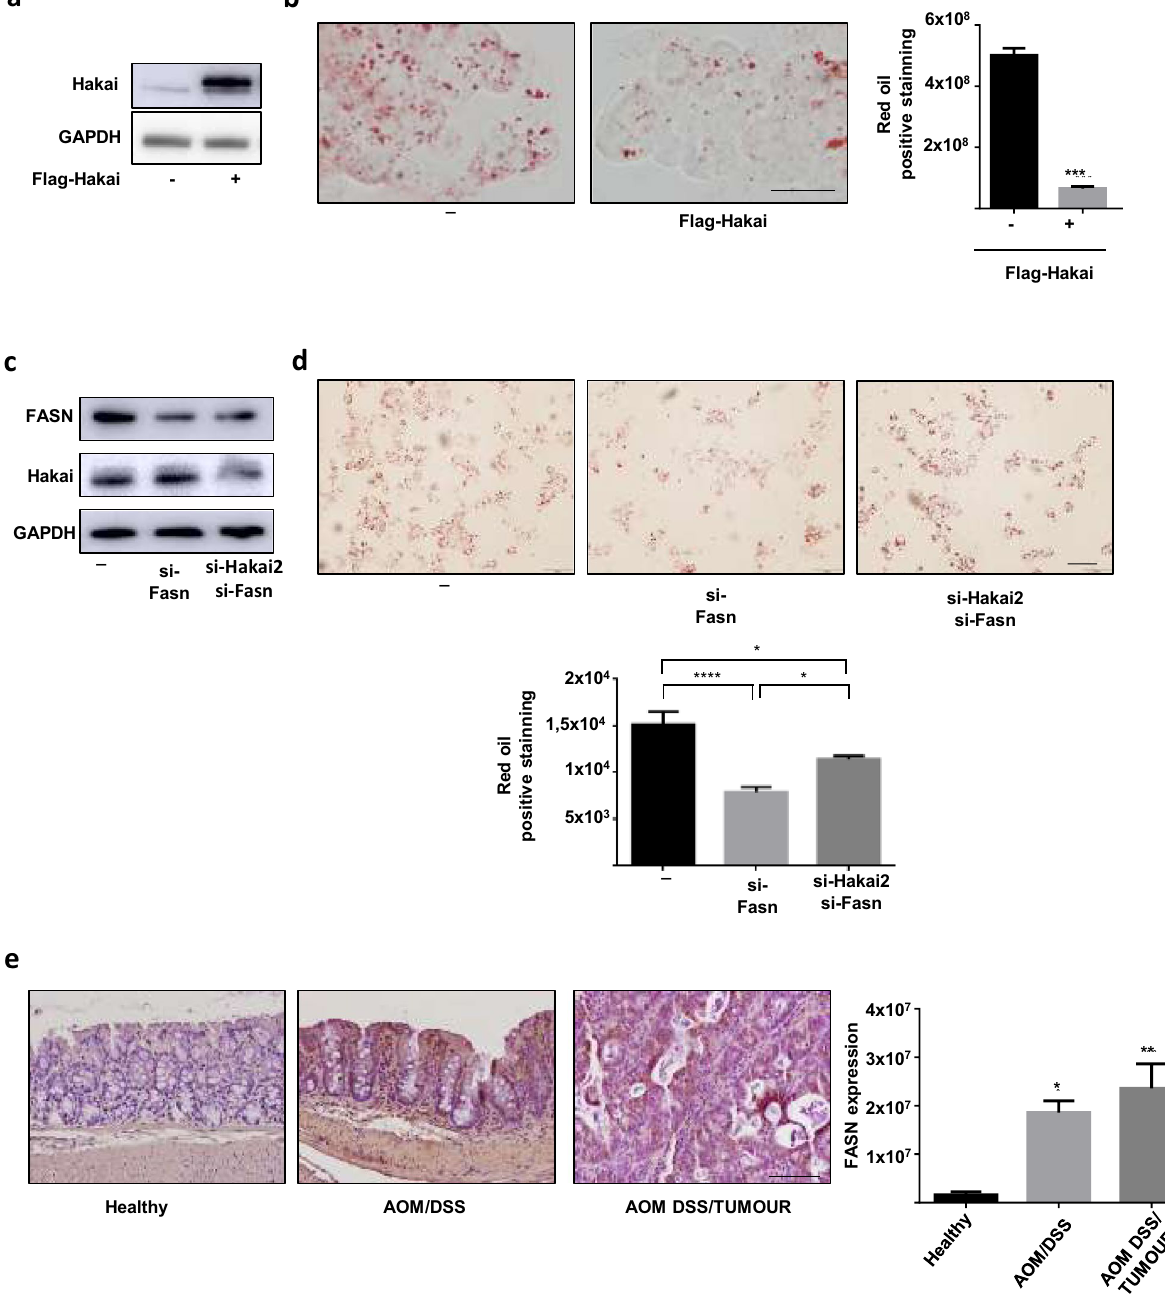
Figure 5. Hakai controls lipid accumulation via FASN. ( a ) Hakai expression in HCT116 cells transfected with Flag-Hakai was analyzed by Western blot analysis and ( b ) the effect on lipid accumulation by staining with Oil Red is shown together with quantification of cell staining (right panel). Scale bar 125 μm. ( c ) HCT116 cells transfected with siRNA-Hakai2 or siRNA control in presence of absence of siRNA-FASN, analyzed by Western blot analysis and ( d ) staining with Oil Red together with quantification of cell staining results is. ( b and d ) Five pictures of each sample were taken and quantified. Values are means ± SD of staining intensity signal scoring per area. Quantification and calibration of the images were performed with Image Analysis Toolbox software for Image J. Kruskal–Wallis with Tukey correction test analyses show statistical differences between overexpression/ silencing of Hakai or FASN and controls (*p < 0.05; **p < 0,01; ***p < 0,001; ****P < 0.0001). Scale bar 50 μm. ( e ) Immunohistochemistry staining (letf panel) and quantification (right panel) of FASN in mouse samples of the AOM/DSS Colitis-associated colorectal cancer model (inflamed epithelium and tumours, healthy mice, n = 7; AOM/DSS-treated mice, n = 14) . Immunohistochemistry staining and quantification were performed as indicated in figure legend 1. Scale bar 125 μm. The blots images were cropped prior hybridization and original blots are included in Supplementary